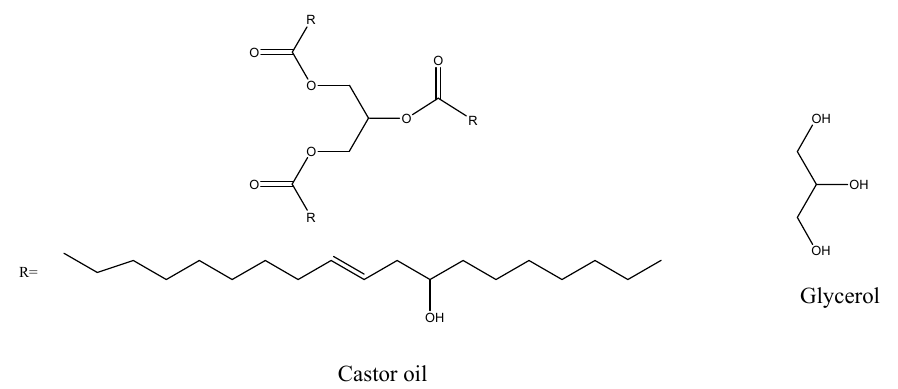
Figure 2. Structure of the castor oil (ricinoleic acid is the main component) and glycerol molecules.